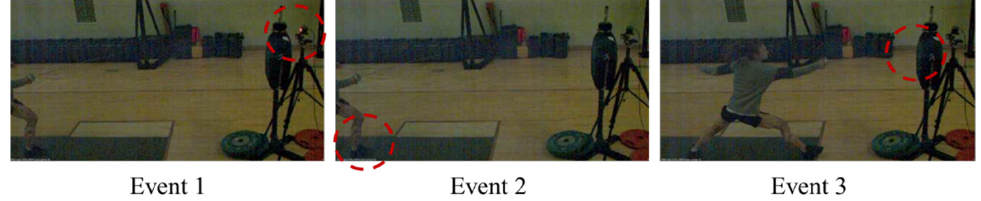
Figure 1. Events during Marche-fente. Red circle means that the Led light was turned on in Event 1, and in Event 2 the foot of dominant leg took off.